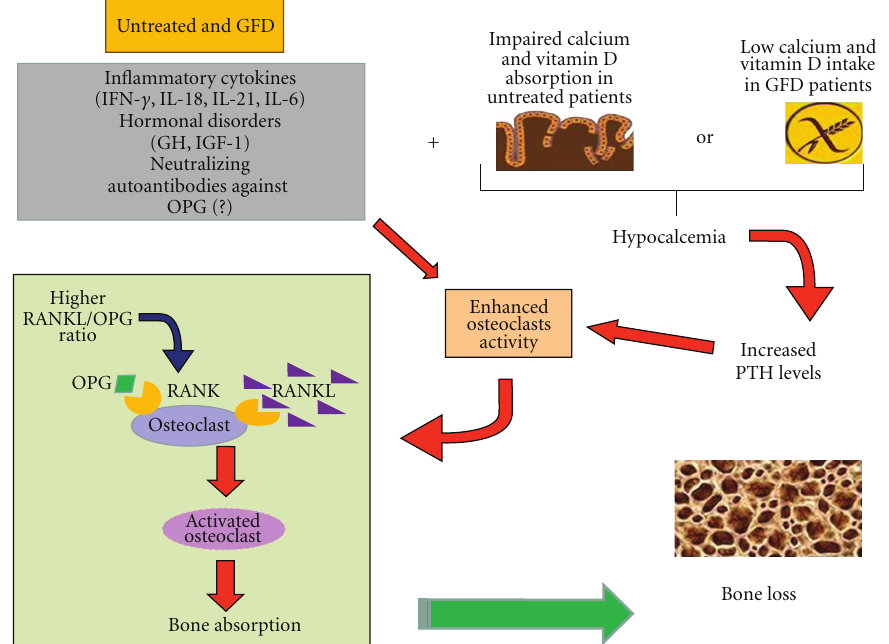
Figure 1: Mechanisms involved in the pathogenesis of bone derangement in celiac disease. GFD: gluten-free diet; IFN γ : interferon-gamma; IL: interleukin; IGF-1: insulin growth factor-1; GH: growth hormone; OPG: osteoprotegerin; RANK/RANKL: receptor activator of nuclear factor kappa B/receptor activator of nuclear factor kappa